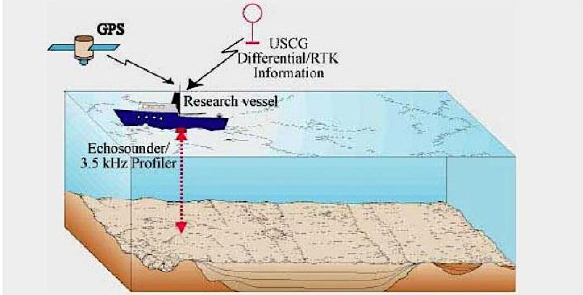
Figure 1. Single Beam Echo Sounder Principle (U.S. Geological Survey Department of the Interior/USGS, https://woodshole.er.usgs.gov/operations/sfmapping/singlebeam